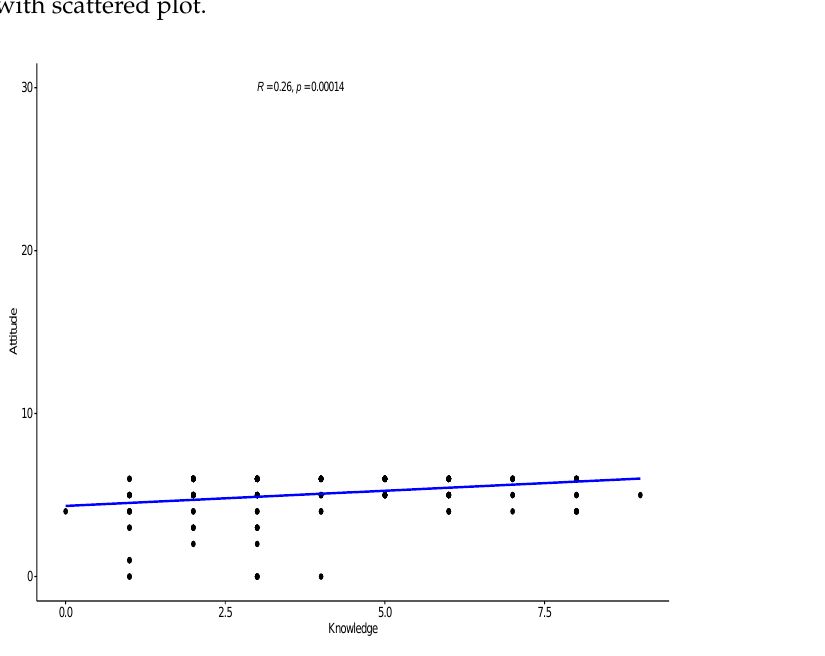
Figure 2. Scatter plot with regression line to show the correlation between knowledge and practice. There is a statistically significant positive weak correlation between knowledge and practice (R = 0.32).